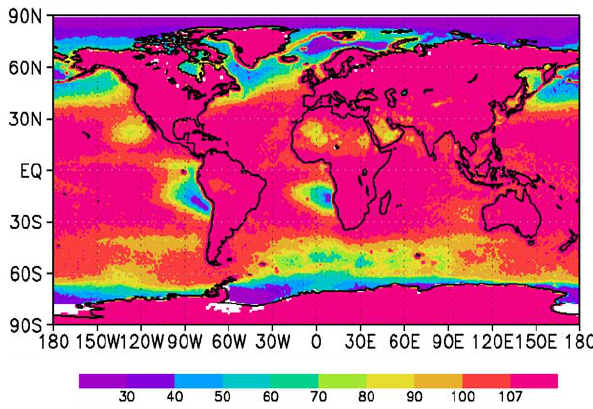
Fig. 2. The number of observations of both T skin (MODIS) and T skin (AIRS/AMSU) data commonly available during the period from September 2002 to August 2011.